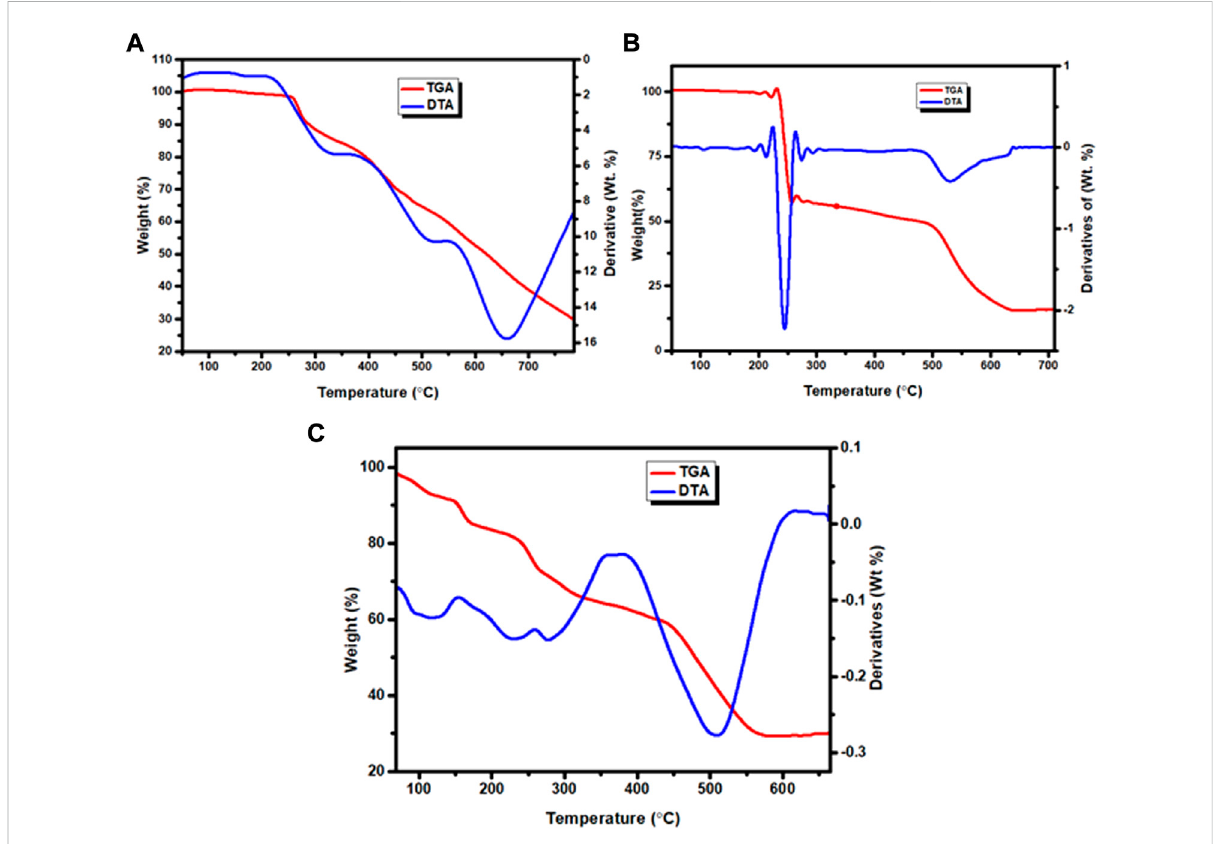
FIGURE 5 TGA and DTA curves: (A) Zn(II), (B) Cu(II) and (C) Ni(II)